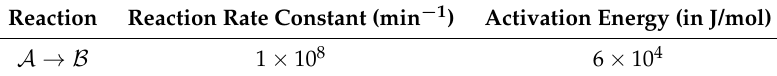
Table 1. Reaction kinetics parameters.